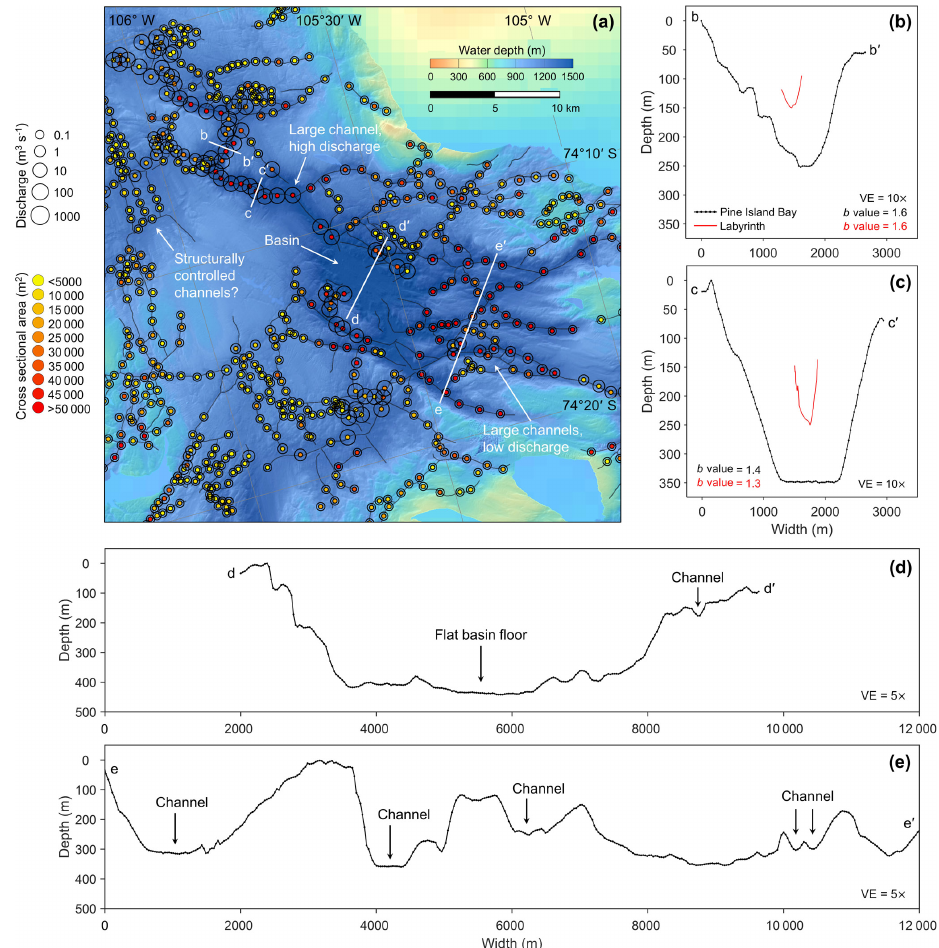
Figure 7. Relationship between modelled water flux and channel size through a channel–basin system. (a) Example channel–basin system in Pine Island Bay. Mapped channels are displayed as black lines. Cross sections used to calculate channel geometries are displayed as dots coloured by channel cross-sectional area. The size of the circle surrounding the dots represents the calculated steady-state water flux through the channels. The locations of the cross profiles displayed in (b–e) are shown. Note the contrast between the large, high-discharge channel to the northwest of the basin and the equally large, but low-discharge, channels flowing into the basin from the southeast. (b, c) Cross-sectional profiles of a large channel in Pine Island Bay compared to some of the largest channels in the Labyrinth. (d) Cross section of a basin in Pine Island Bay. (e) Cross section of a series of channels feeding the basin from the southeast. Vertical exaggeration (VE) is 10 × in (b, c) and 5 × in (d, e)